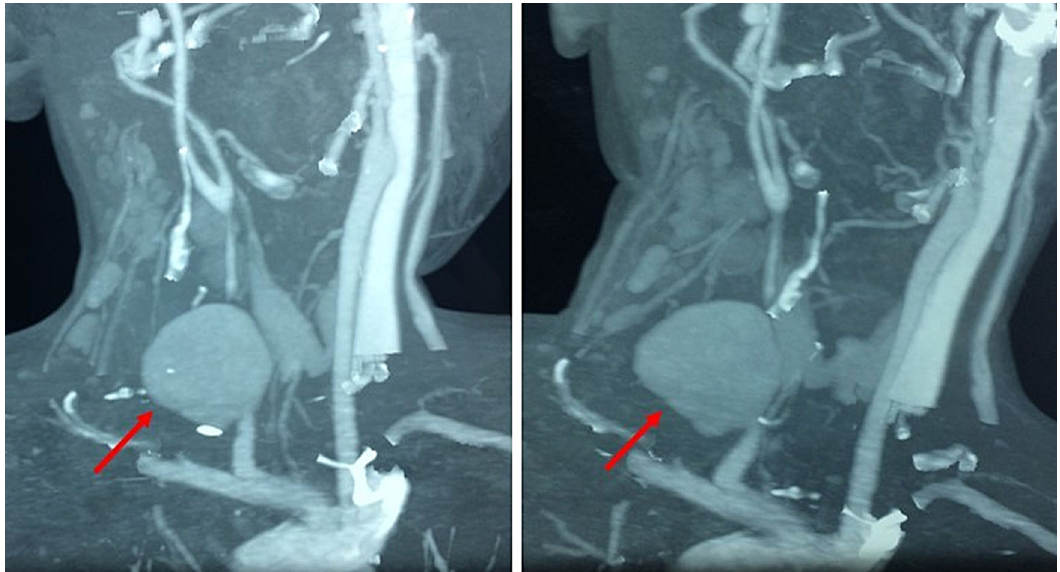
Figure 2. Cervical computed tomography angiogram showing a 3 cm right common carotid artery pseudoa- neurysm beginning at 2 cm of its origin and at a distance from the carotid bifurcation (red arrow), with the presence of multiple cervical lymphadenopathies.